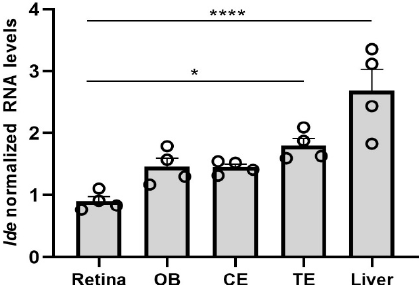
Figure 1. Expression of Ide in wild-type mouse tissues. Gene expression of Ide was analyzed by RT-qPCR in the indicated adult tissues. Dots represent individual animals, and bars represent the mean (+SEM) ( n = 4 mice per group). Data were normalized to Tbp RNA levels. Gene expression was compared using a 1-way ANOVA, followed by Dunnett’s multiple comparison test. **** p < 0.0001; * p < 0.05. OB, olfactory bulb; CE, cerebellum; TE, telencephalon.